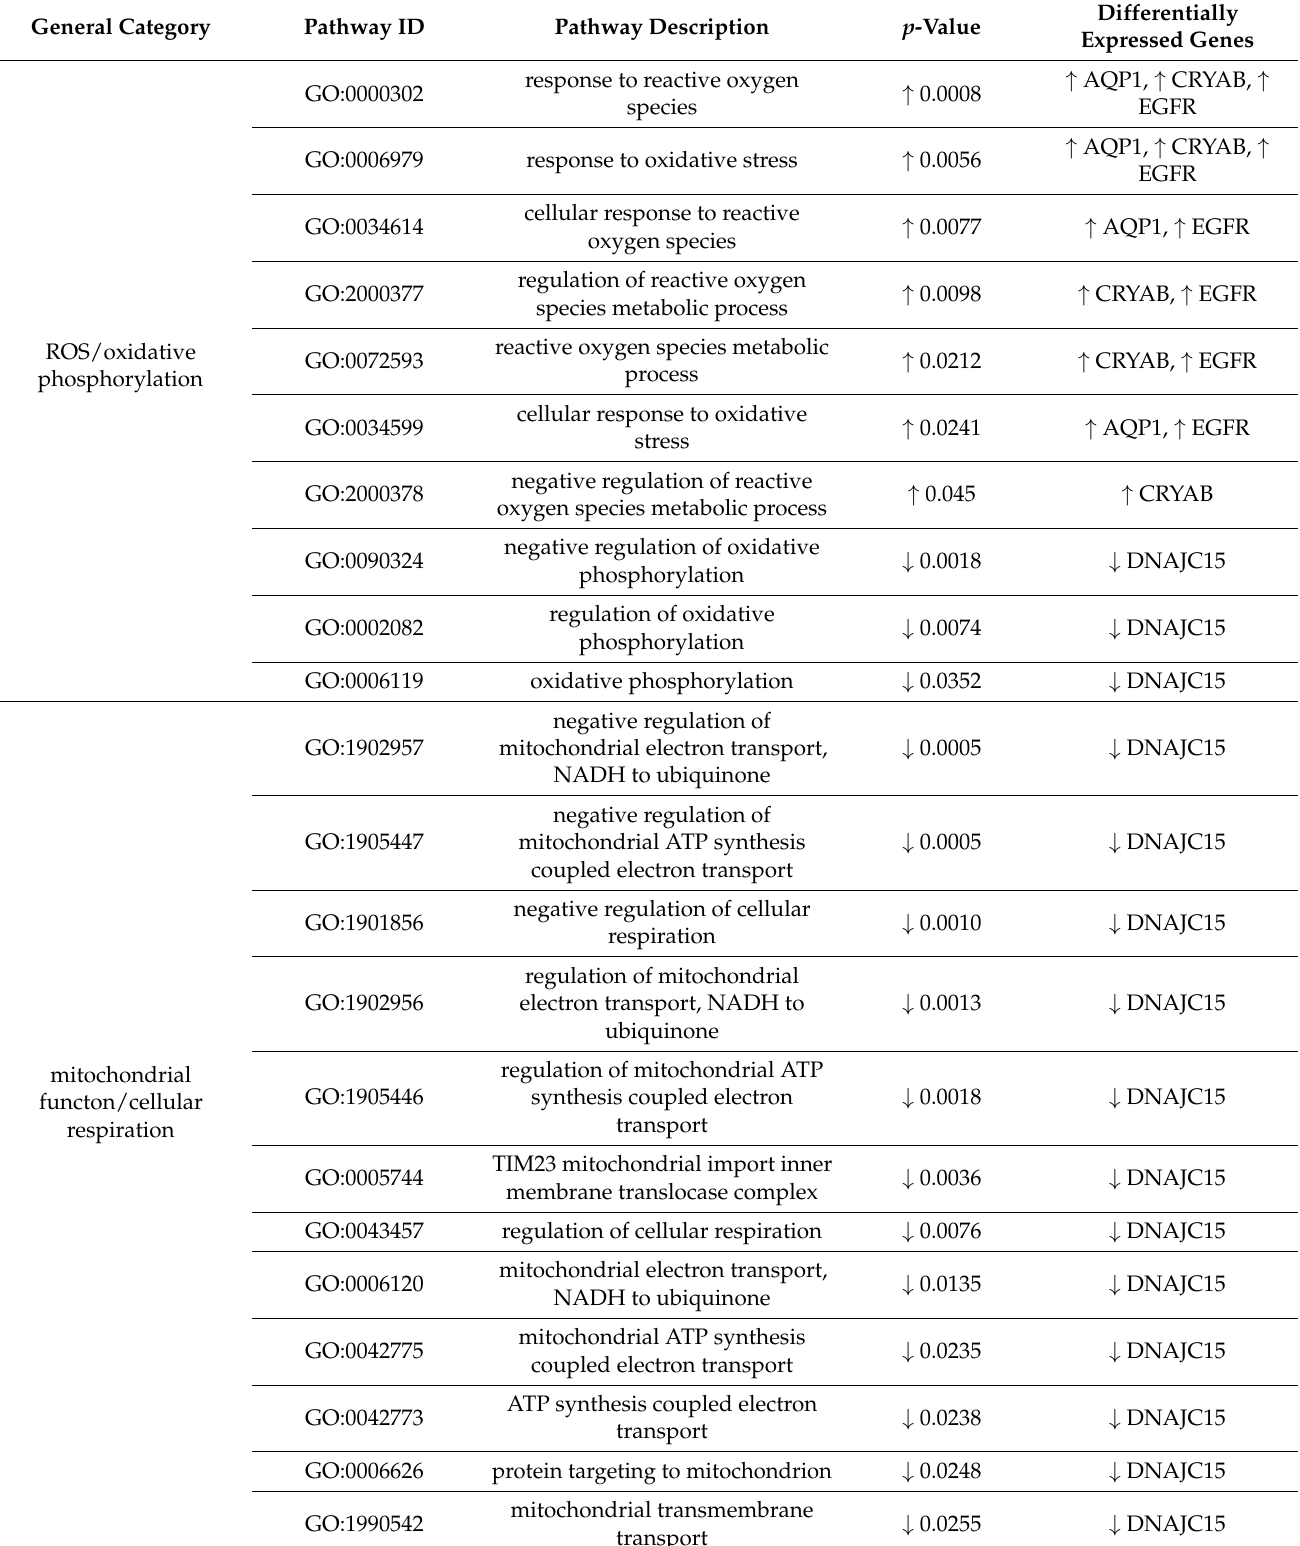
Table 1. Pathway analysis of genes differentially expressed between the resistant (1226 and 1254) and sensitive (2238, 2326, 1236, 1267) organoid models. Gene ontology IDs are listed under pathway